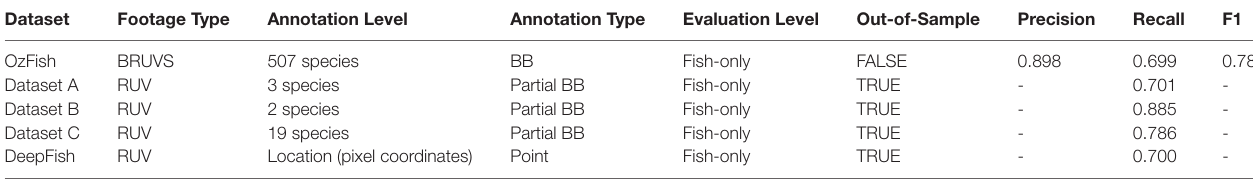
TABLE 2 | Summary of the datasets used for evaluating the object detection performance.